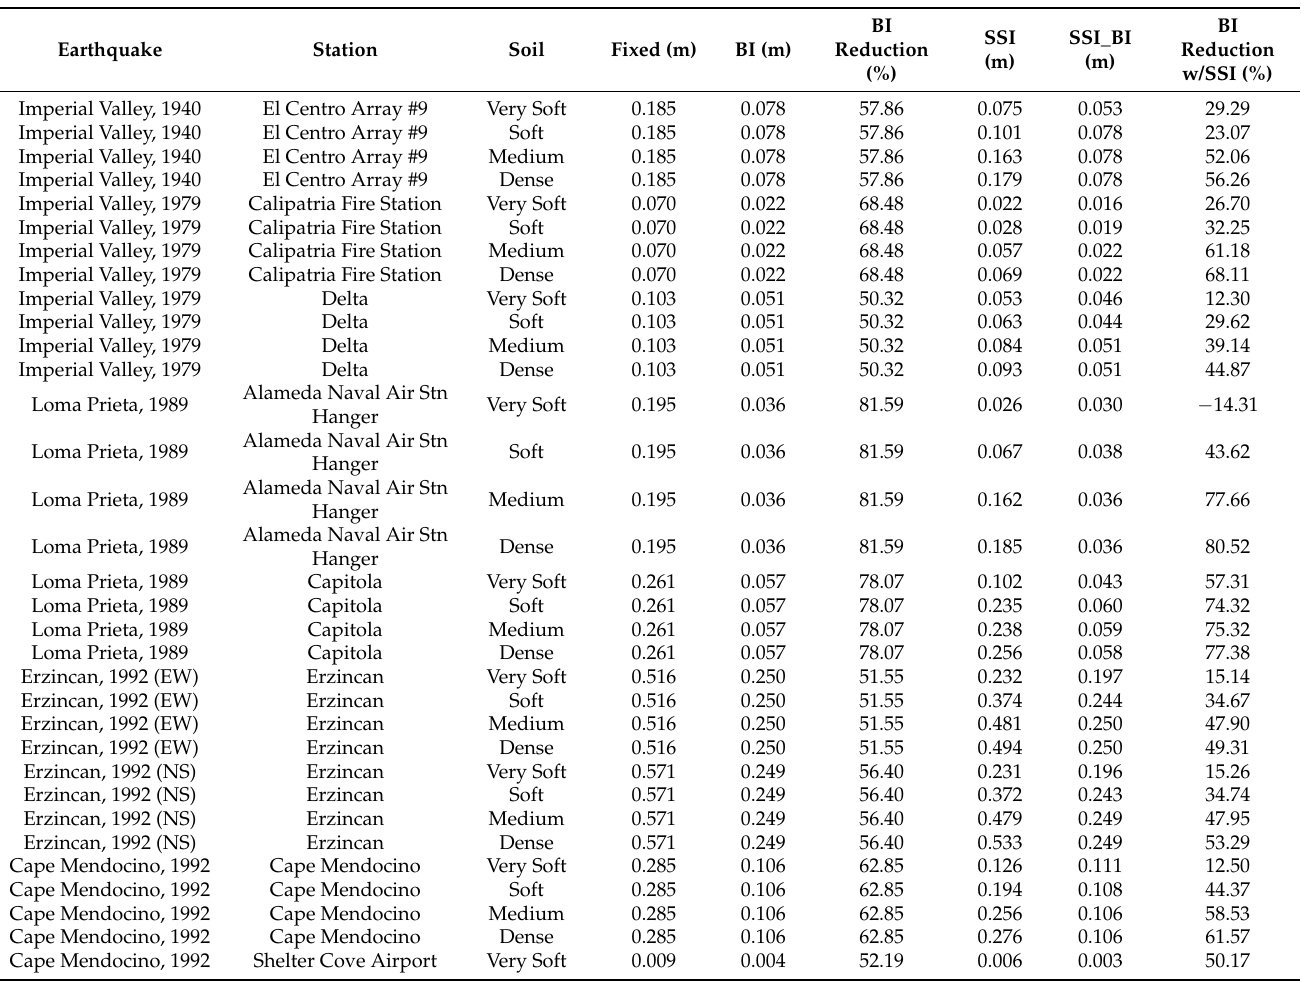
Table 8. Maximum roof displacement values of the ten-story